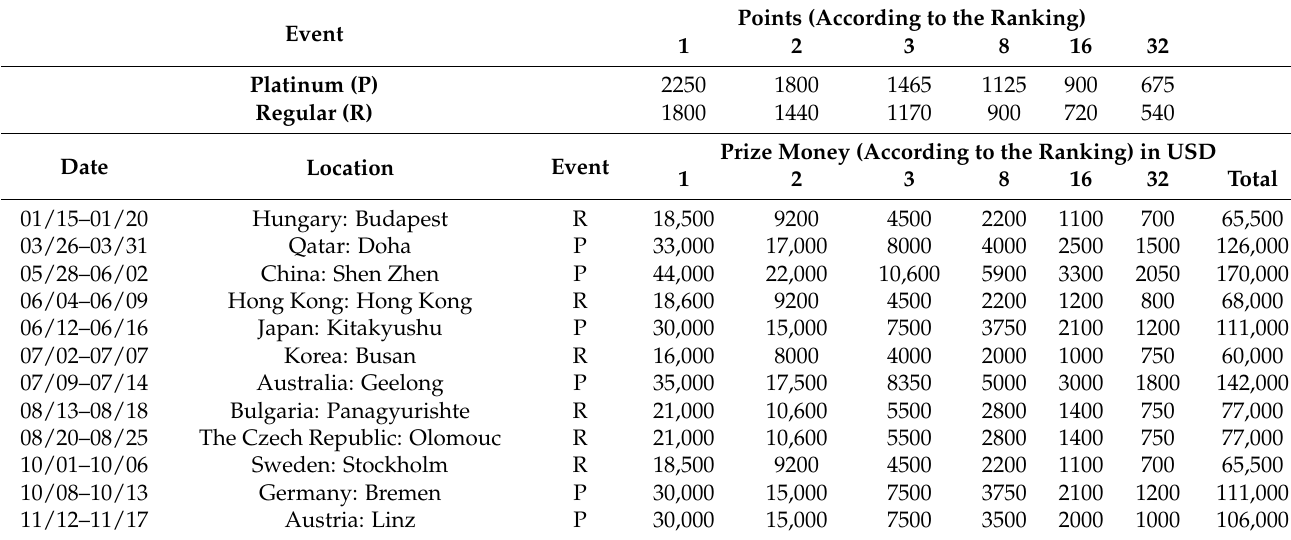
Table 1. A summary of the 2019 ITTF World Tour event.